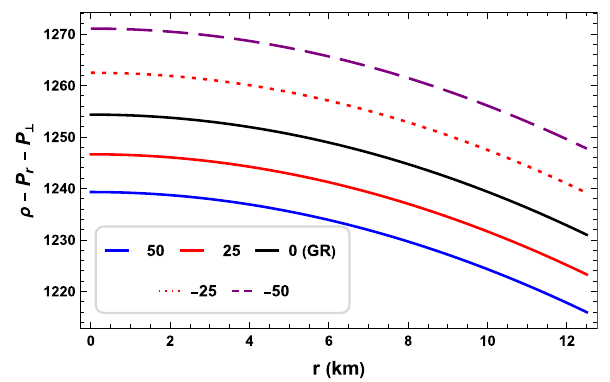
Fig. 14 SEC against radial distance r in PSR J0348+0432 for different α values in 5D